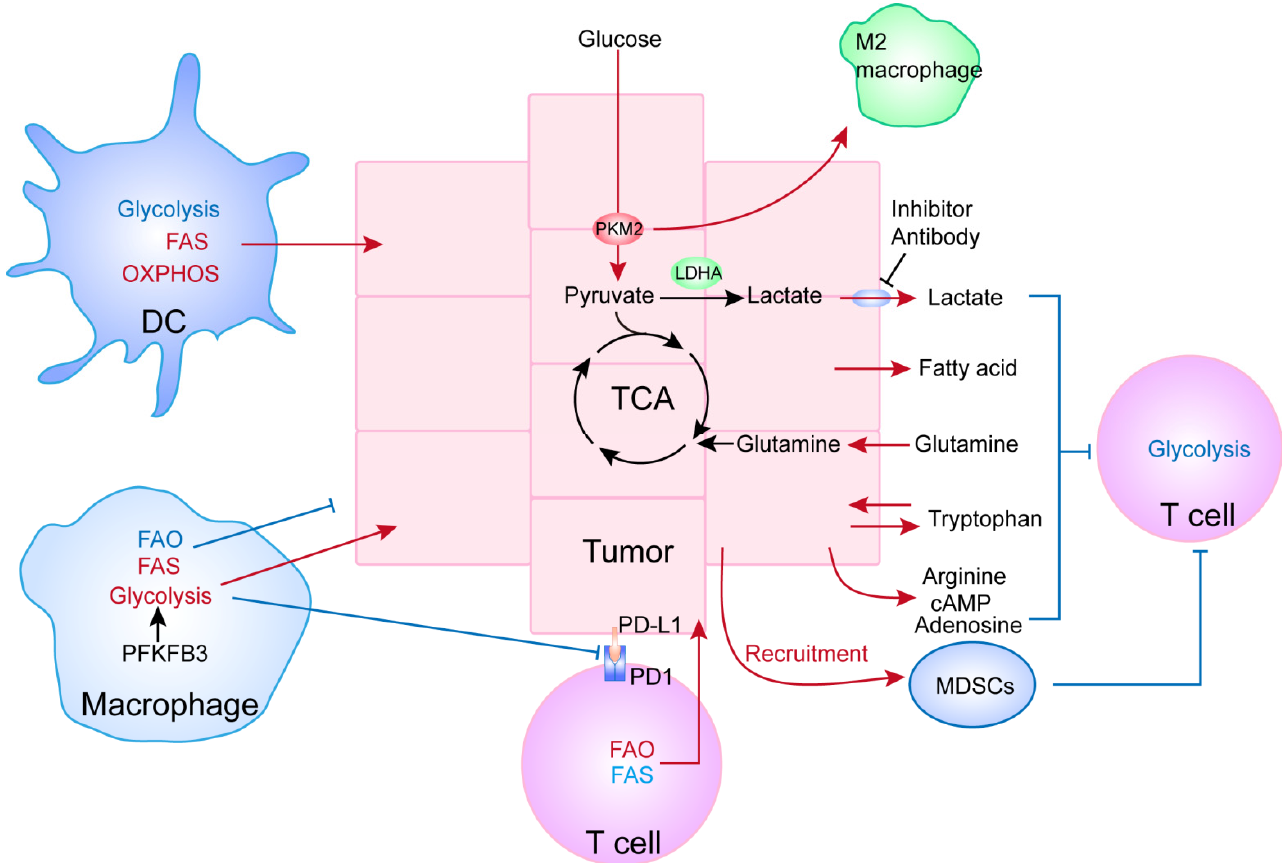
Figure 5. Crosstalk and interplay between tumor and immune cells through metabolic reprogramming. This illustration shows that the reprogramming of certain metabolic pathways in tumor cells, such as glycolysis, can offer not only a survival advantage to the tumor cells, but can also change the behavior/function of immune cells. Similarly, the metabolic rewiring of immune cells can act on tumor cells reciprocally to facilitate tumor progression. The red arrows and text indicate enhanced metabolic processes, whereas the blue arrows and text indicate suppressed activities. The black arrows and text indicate baseline